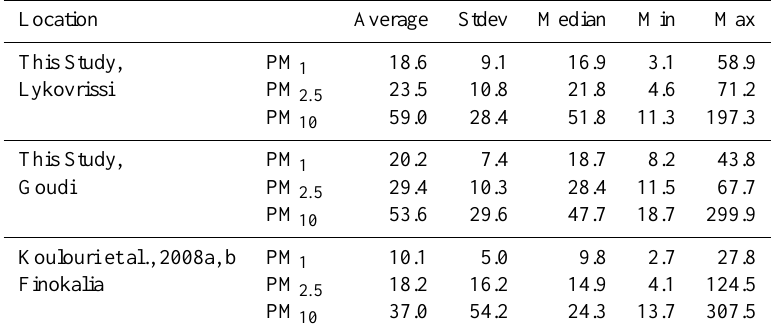
Table 1. Annual mean concentrations of PM fractions (µgm − 3 ) measured in Lykovrissi, Goudi and Finokalia from September 2005 to August 2006 and basic descriptive